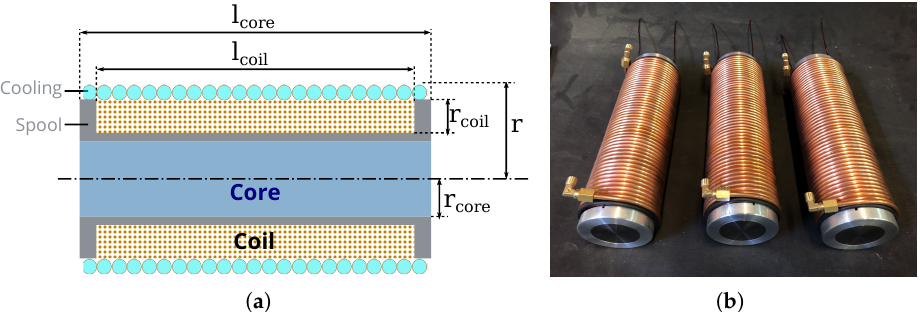
Figure 9. ( a ) The electromagnet’s shape, with its core, coil winding and cooling part. The spool part allows containing the winding and separating it from the core. ( b ) The implemented electromagnet